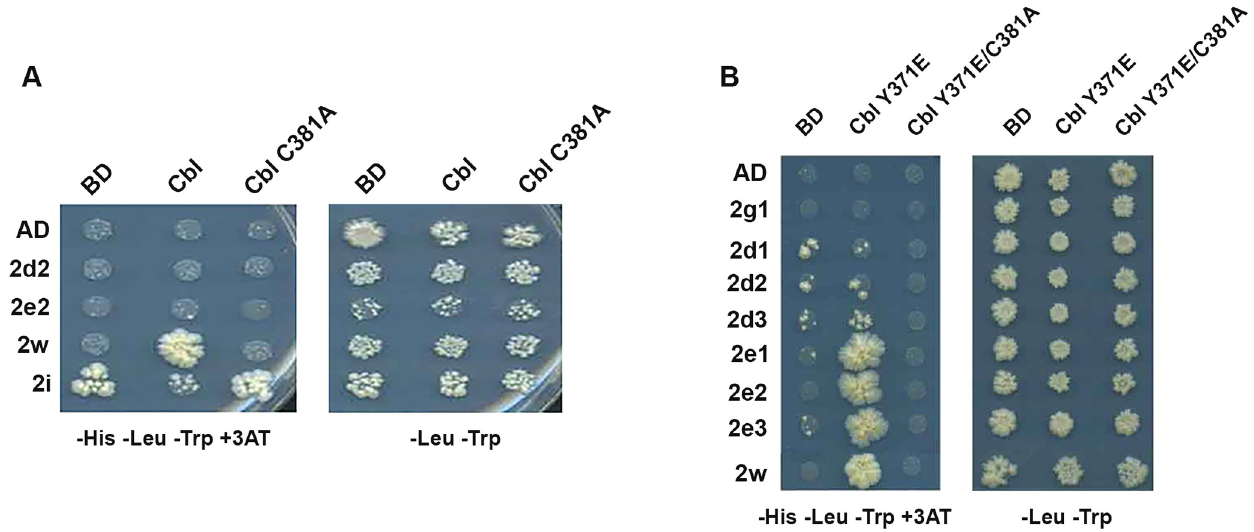
Fig 2. E2s interacting with intact RING finger domain of Cbl. (A) Representative yeast colonies transformed with wild-type Cbl or RF Mutant Cbl C381A as the bait and with the indicated E2s as prey. Empty DNA-binding domain (DB) and empty activation domain (AD) vectors were used as negative controls for bait and prey, respectively. (B) Representative yeast colonies transformed with activated Cbl Y371E or activated RF mutant Cbl Y371E/C381A as the bait with the indicated E2s as prey. Ube2e family members and Ube2w interact with activated Cbl Y371E but not with activated RF mutant Cbl Y371E/C381A. For both A and B, the left panel shows growth of the yeast on -His, -Leu, -Trp, +3AT interaction selective media and the right panel shows grow on -Leu, -Trp media to confirm that the yeast received both bait and prey plasmids.